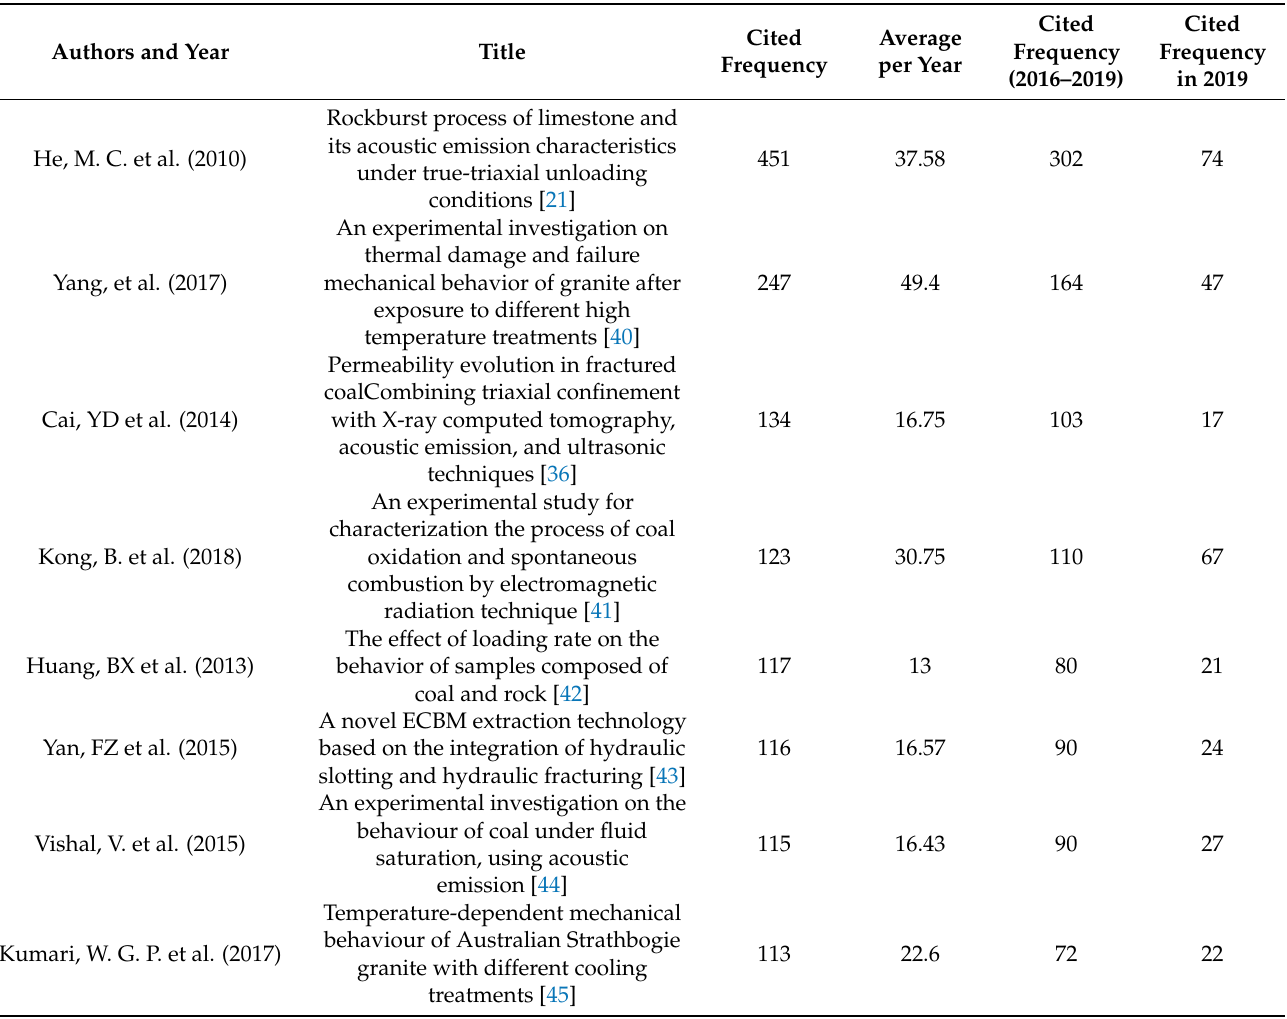
Table 5. Cited data analysis of the